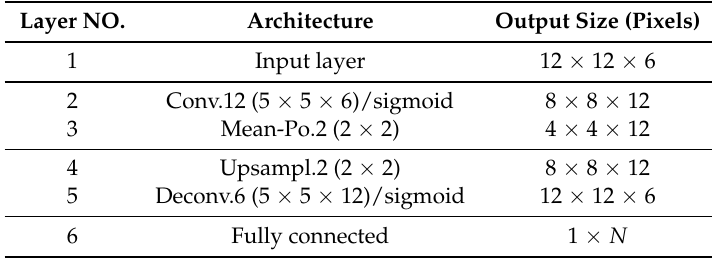
Table 1. The Framework and Parameters Configuration of